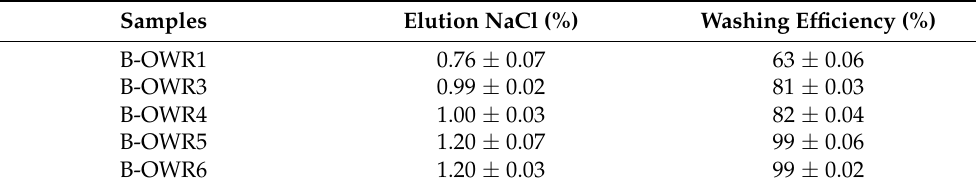
Table 2. Maximum NaCl elution volume depending on water.